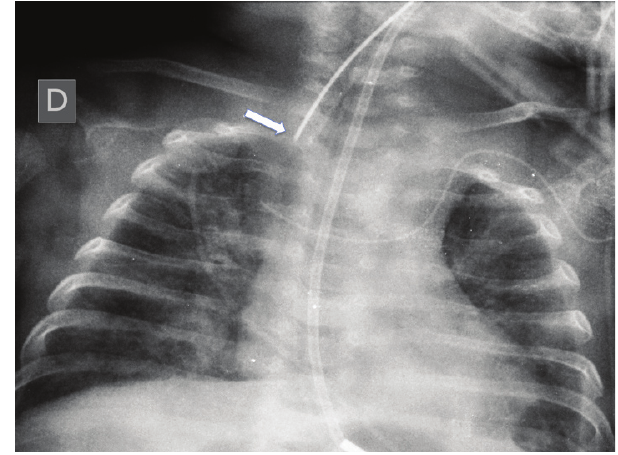
Figure 1. Prenatal ultrasound showing the neck mass. Figure 2. Endotracheal tube displaced to the right